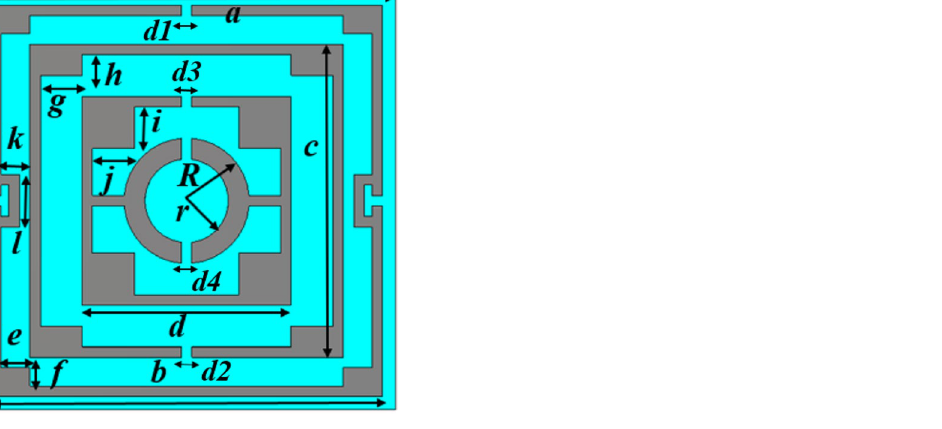
Figure 1. Layout of the proposed unit cell.